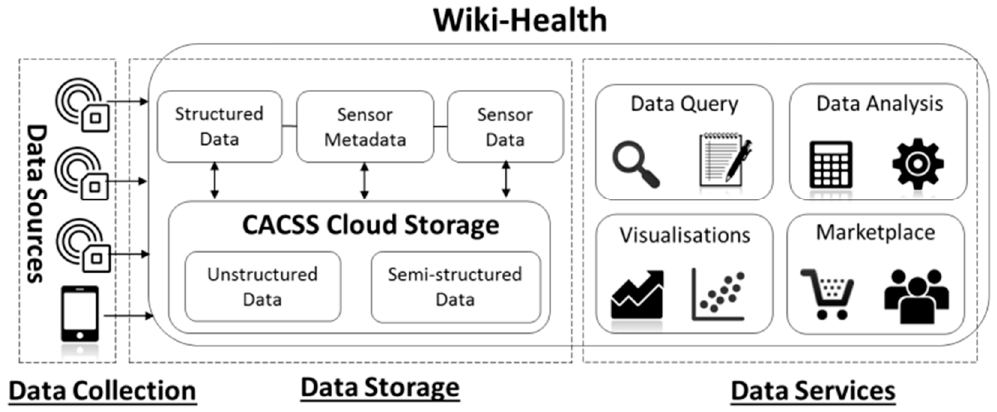
Figure 1. The overall system architecture of Wiki-Health.